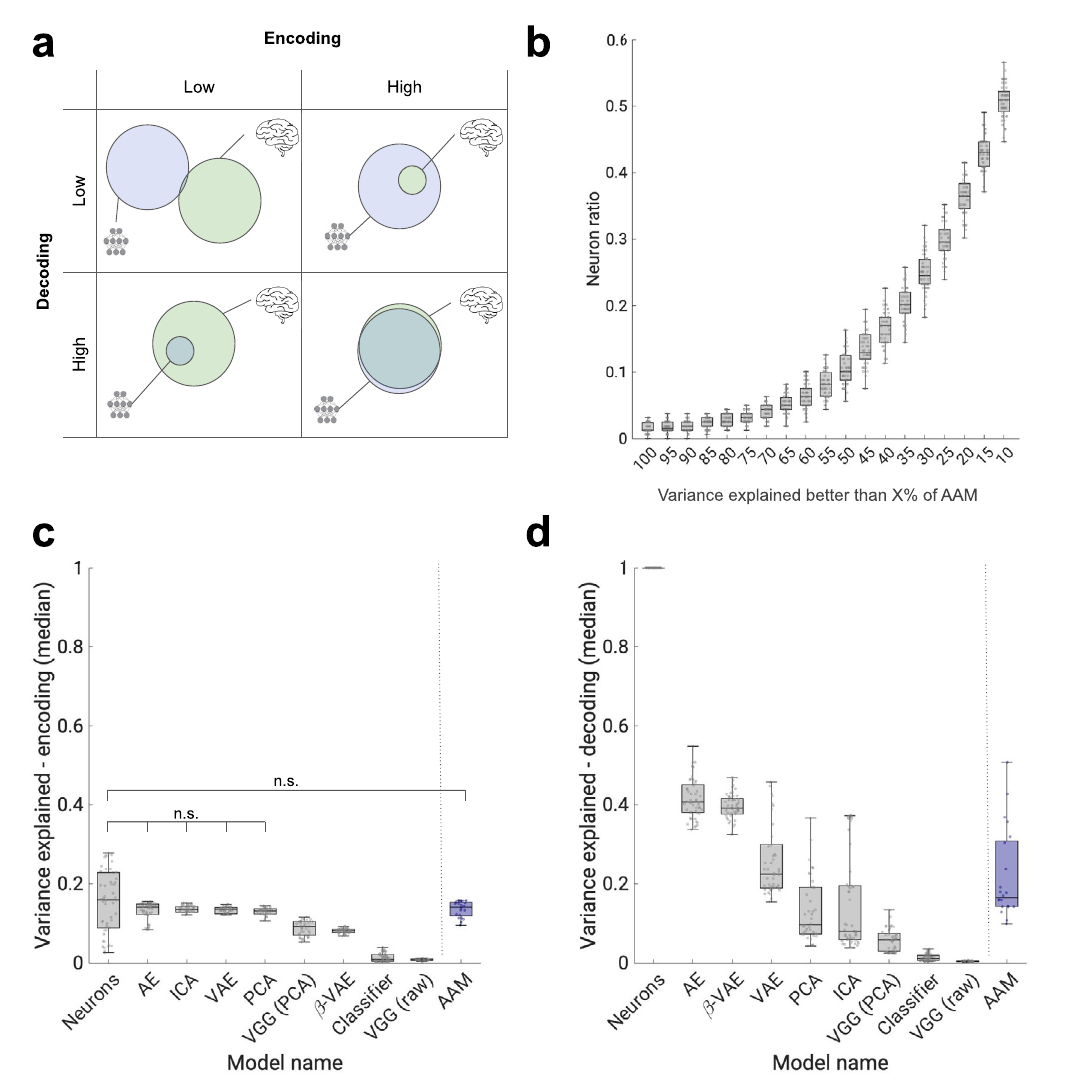
Fig. 6 Variance-explained results. a Schematic representation of linearly accessible information overlap between the population of neurons (green) and model representation (blue) corresponding to the different combinations of magnitudes of the encoding and decoding scores. b Ratio of total neuron population ( n = 159) for which single β -VAE units explain more variance than X % of variance explained by the best baseline model (AAM, 50 units). See Supplementary Fig. 3 for more details. Source data are provided as a Source Data fi le. c Encoding variance explained. No signi fi cant difference is found between encoding variance explained by neuron subsets and AE, ICA, VAE, PCA and AAM ( β -VAE p = 2.4689 e – 08, AAM p = 0.1211, VGG (PCA) p